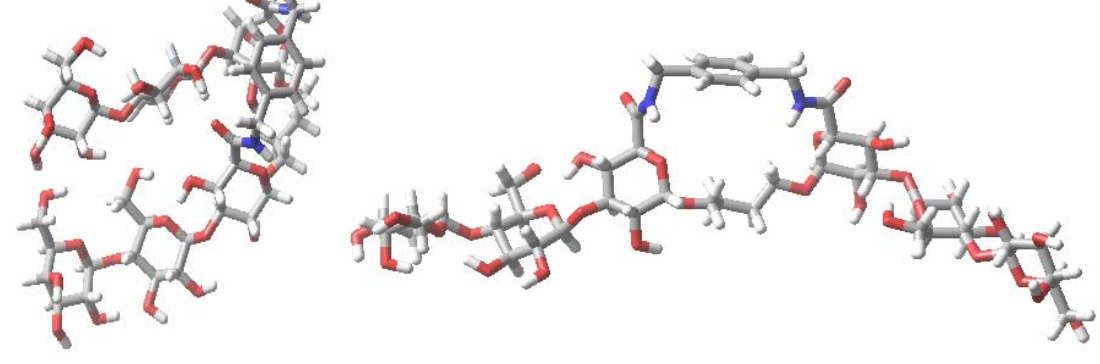
Figure 7. Examples of stacked (left) and extended (right) conformers of the lactose- presenting macrocyclic glycocluster 5 .